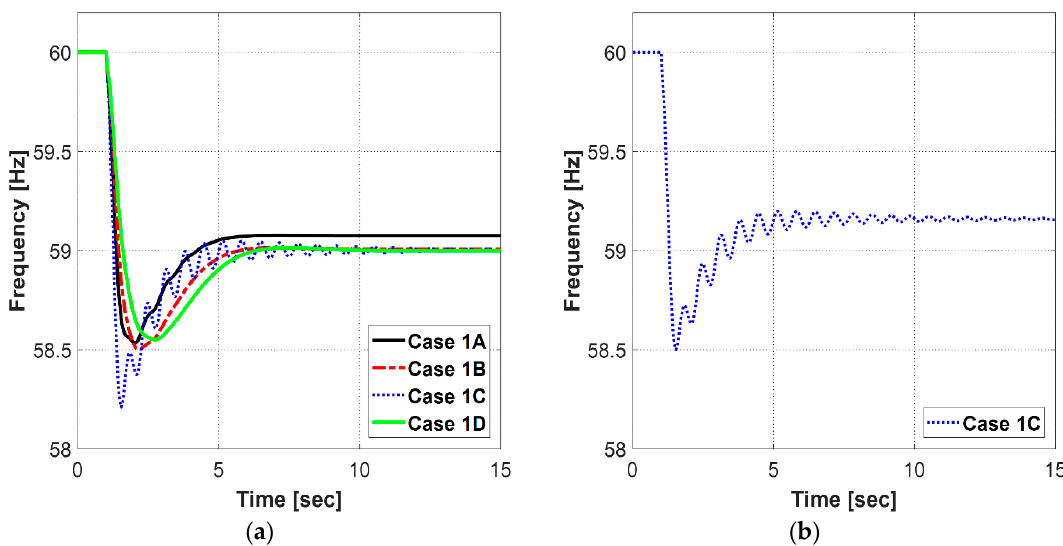
Figure 6. Frequency responses without energy storage system (ESS): ( a ) after credible contingency based on the quasi-steady-state (QSS) frequency (Cases 1A–1D); ( b ) after credible contingency based on the instantaneous frequency (Case 1C).